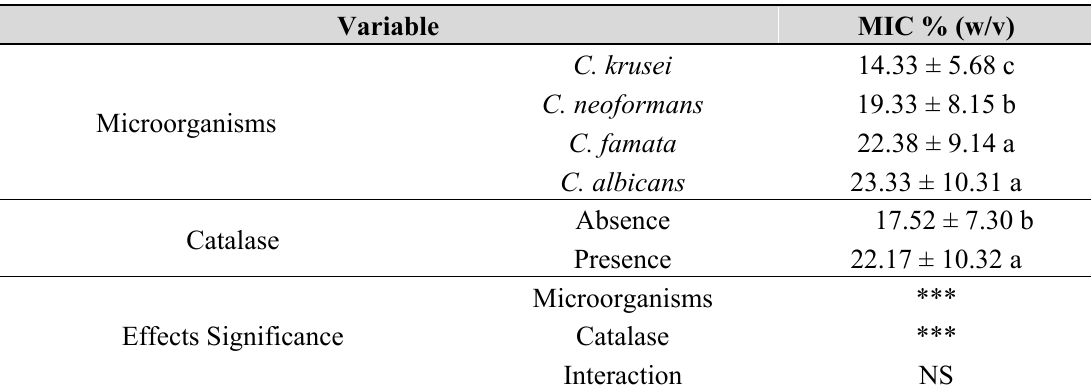
Table 2. Effect of the yeasts species, presence of catalase, and their interaction on the Minimum Inhibitory Concentration